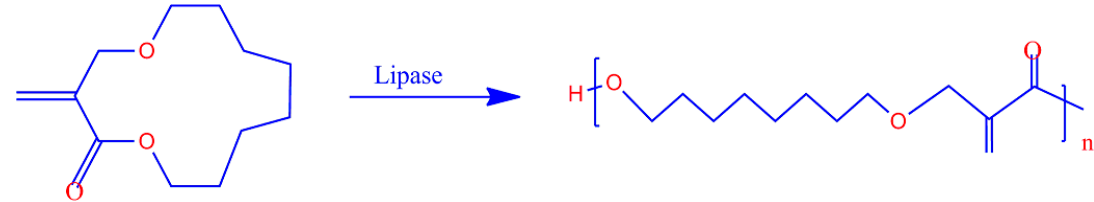
Figure 4. Lipase-catalyzed chemoselective macrocyclic monomer 2-methylene-4-oxa-12-dodecanolide polymerization